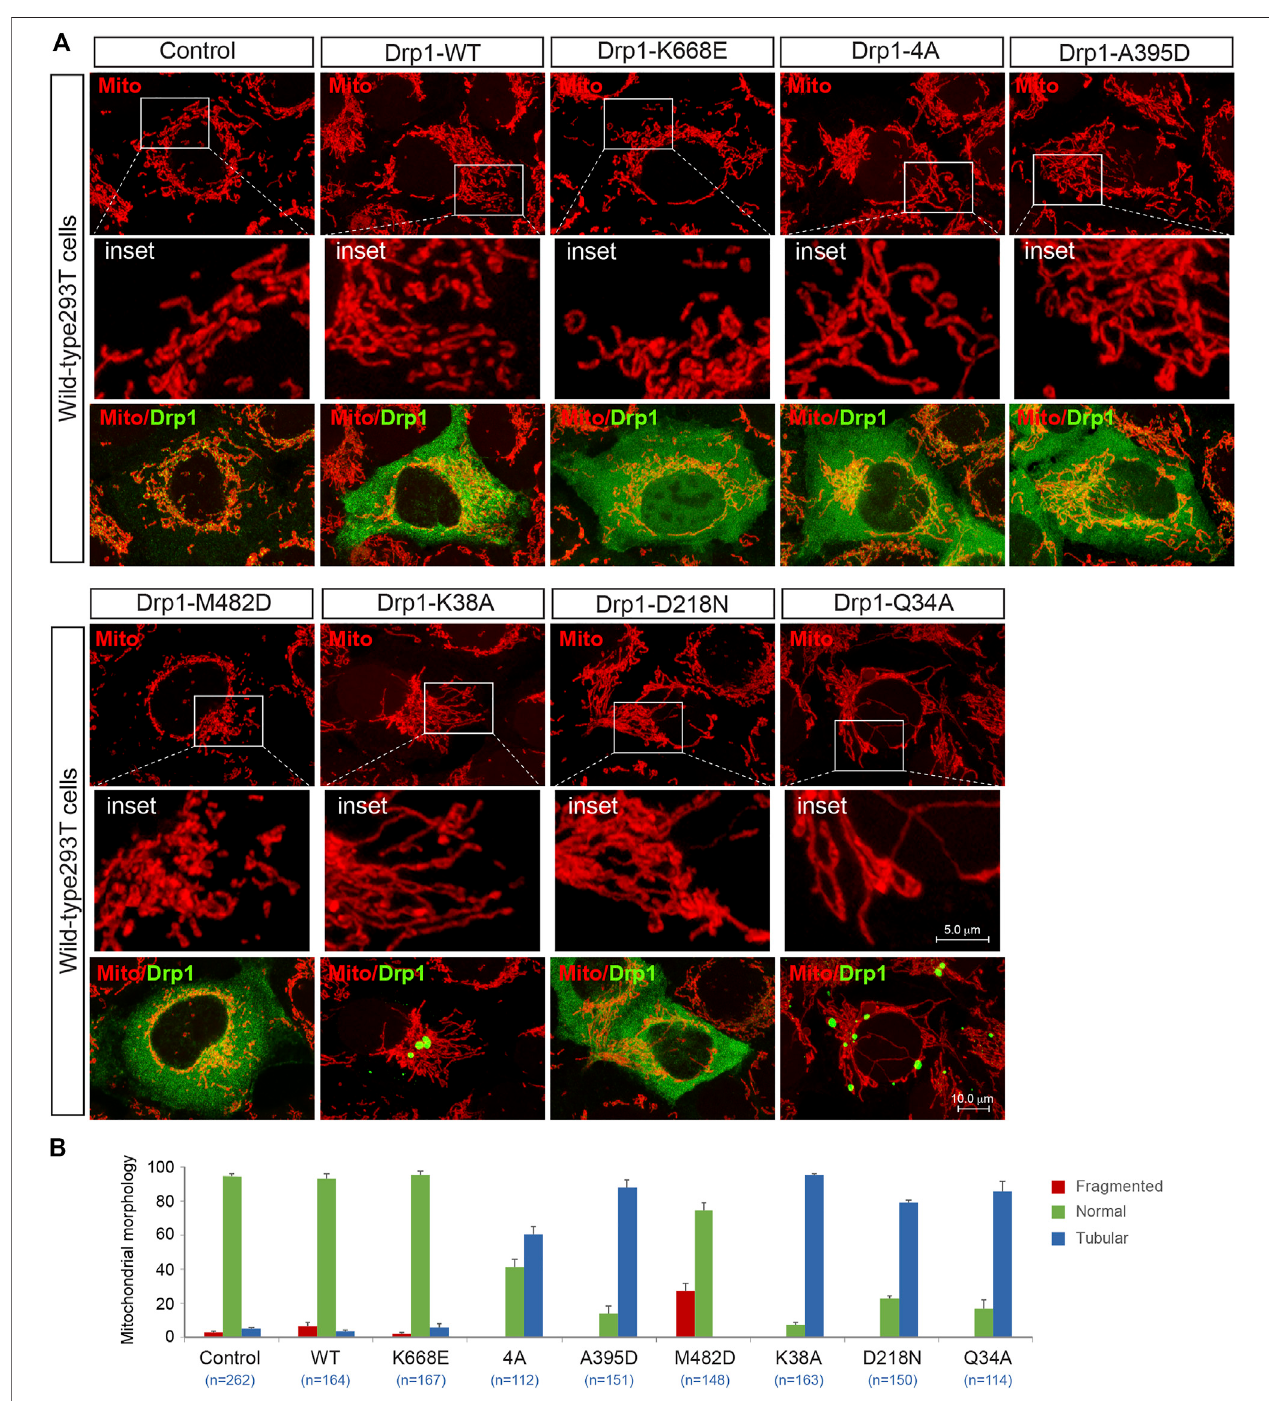
FIGURE 8 | The function-de fi cient Drp1 mutants impair endogenous Drp1-mediated fi ssion. (A) Confocal images of mitochondrial morphology and Drp1 distribution in WT 293T cells transfected with empty vector, exogenous Drp1-WT or Drp1 mutants as indicated. Cells transfected with indicated plasmids were stained with MitoTracker (red) in vivo before fi xation, followed by immunostaining with anti-Drp1 antibody (green). Insets represent high magni fi cation views of the boxed areas. (B) Percentages (mean ± S.E.M.) ofcells with indicated mitochondrial morphologies inWT 293Tcells transfectedwithEmpty vector, exogenous Drp1-WT or Drp1 mutants shown in (A) . n represents the number of cells analyzed.